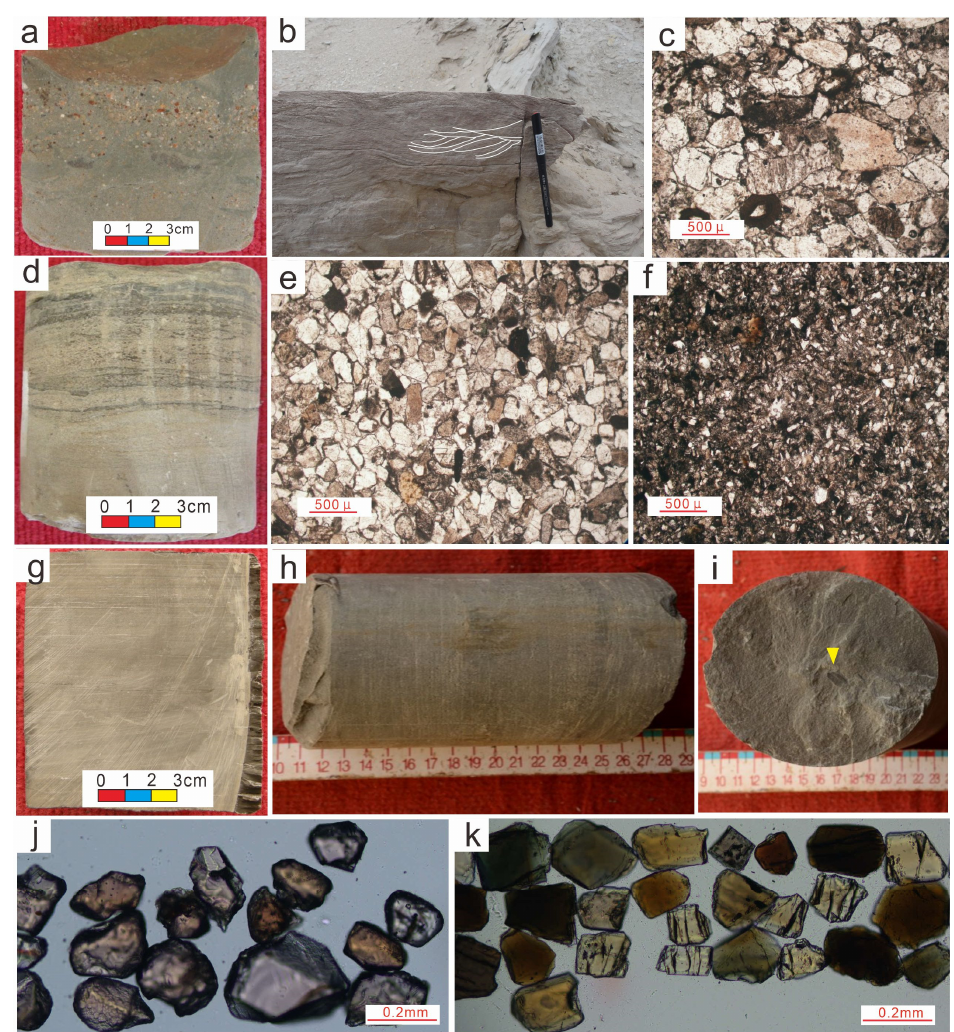
Figure 2. Photographs and micrographs of the sandstones and heavy minerals. ( a ) Massive con- glomerate (Well Yue 68, 2205.5 m); ( b ) Trough cross-bedding of Dongchaishan outcrop section; ( c ) coarse sandstone under plane-polarized light, the detrital grains are sub-rounded and sub-angular in shape (Dongchaishan outcrop); ( d ) fine sandstone, microwave-like bedding in the upper layer and small trough cross-bedding in the lower layer (Well LV13, 2525.5 m); ( e ) medium sandstone under plane-polarized light with subrounded to rounded grains (Dongchaishan outcrop); ( f ) fine sandstone under plane-polarized light (Dongchaishan outcrop); ( g ) brownish-red mudstone, horizontal bedding (Well LV13, 4308.2 m); massive grayish mudstone ( h ) and carbon debris ( i ) (Well W15, 3086.8 m); ( j ) subangular to subrounded shaped garnet grains (Well Z2); ( k ) subangular to subrounded shaped tourmaline grains (Well YD103).